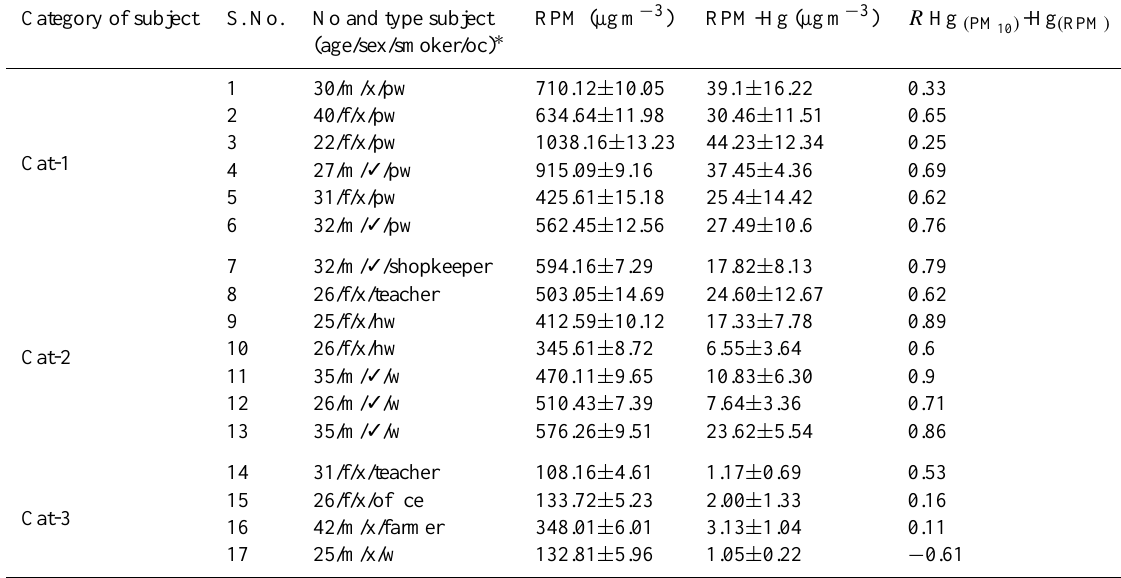
Table 4. Average integrated personal exposure of Hg levels (RPM-Hg) and its correlation with ambient PM10-Hg around integrated steel plant, Bhilai.